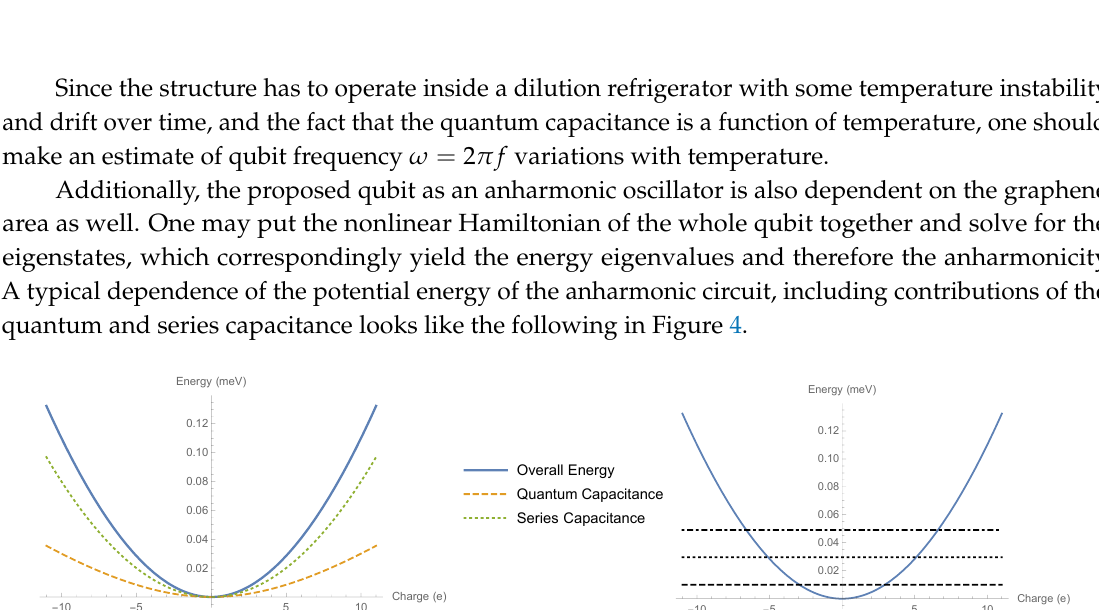
Figure 3. Illustration of a combined nonlinear quantum capacitance and Josephson junction (JJ) design.